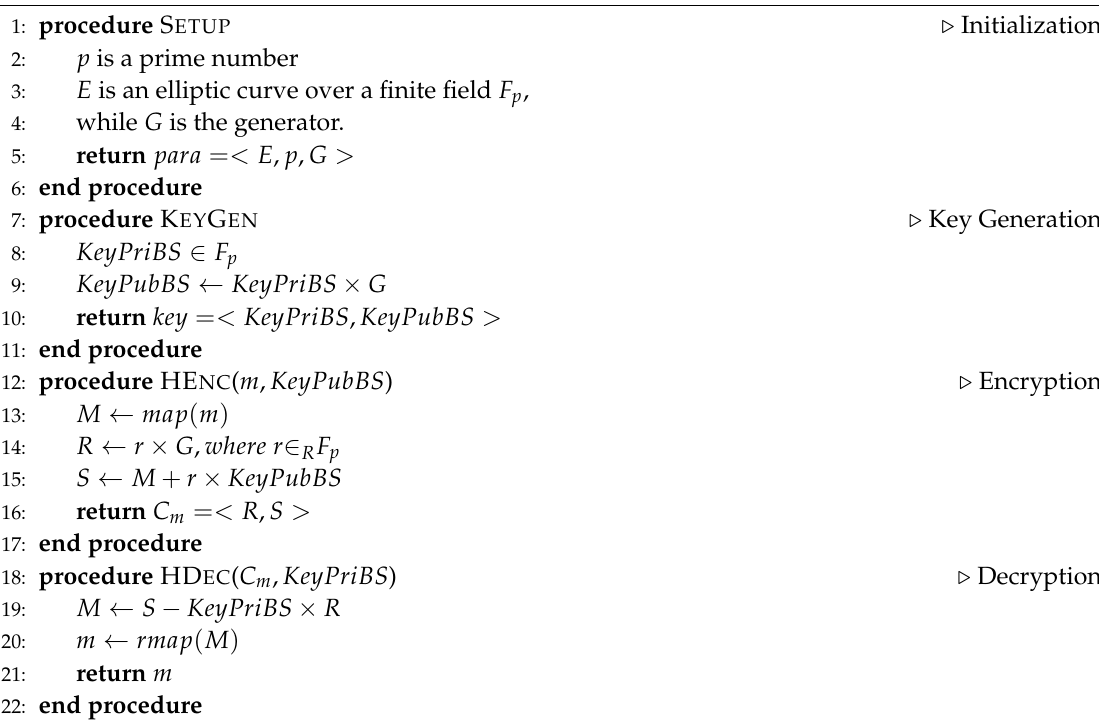
Algorithm A1 Homomorphic encryption